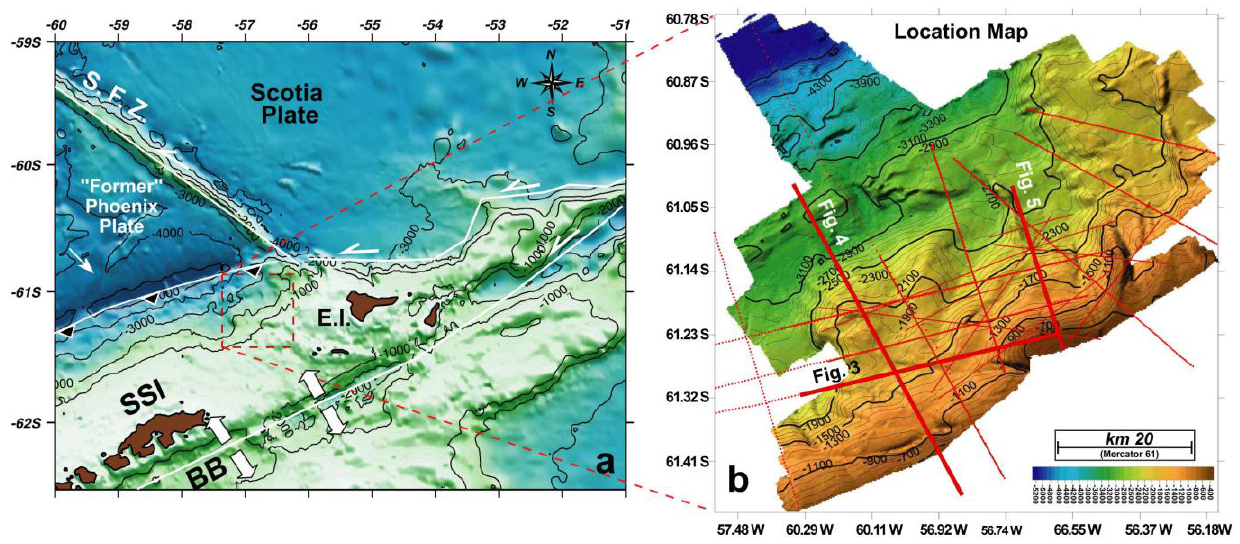
Figure 1. Shaded relief of low resolution bathymetric data downloaded by the website at [37]. Mercatore projection is adopted. Thick white arrows indicate a schematic NW-SE extension across Bransfield Basin (B.B.). The direction of the subduction ―Former‖ Phoenix Plate is indicated with thin white arrow, while transform fault movements are indicated with double white thin arrows. The dashed rectangle indicates the analyzed area. Location of seismic lines analysed in this work are indicated as thin solid lines; the thick lines refer to the line shown in Figures 2, 4 and 5. E.I.: Elephant Island; F.T.P.: